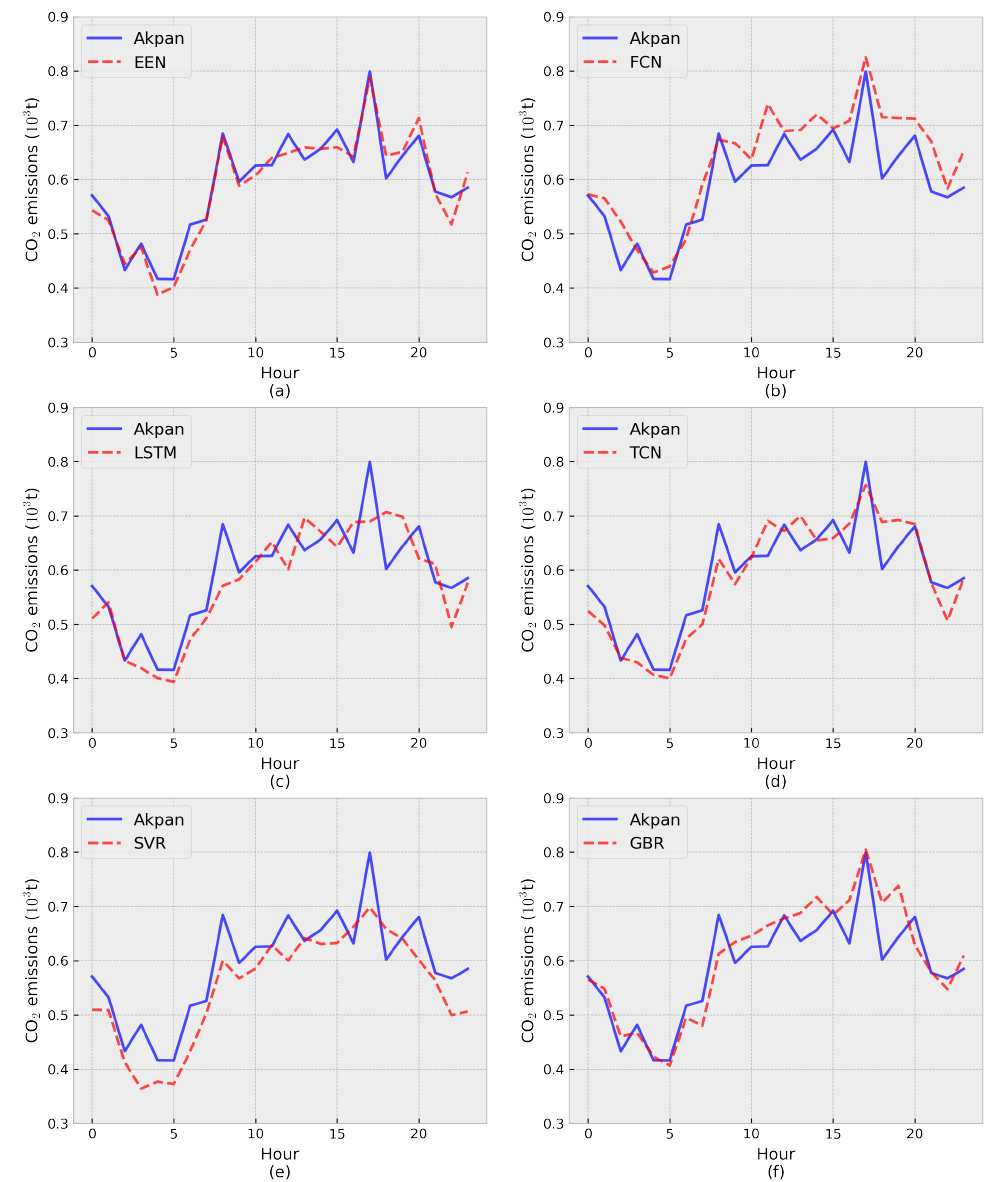
Figure 12. Comparison of estimated hourly CO 2 emissions. ( a – f ) compare the estimated hourly CO 2 emissions between Akpan and EEN , FCN , LSTM , TCN , SVR , and GBR ,